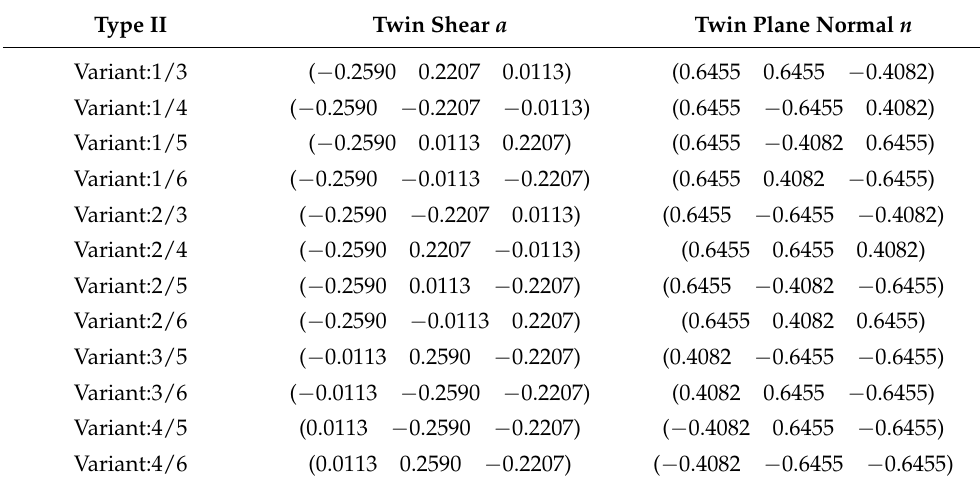
Table 4. Twin elements for type II twins with different variant combinations.